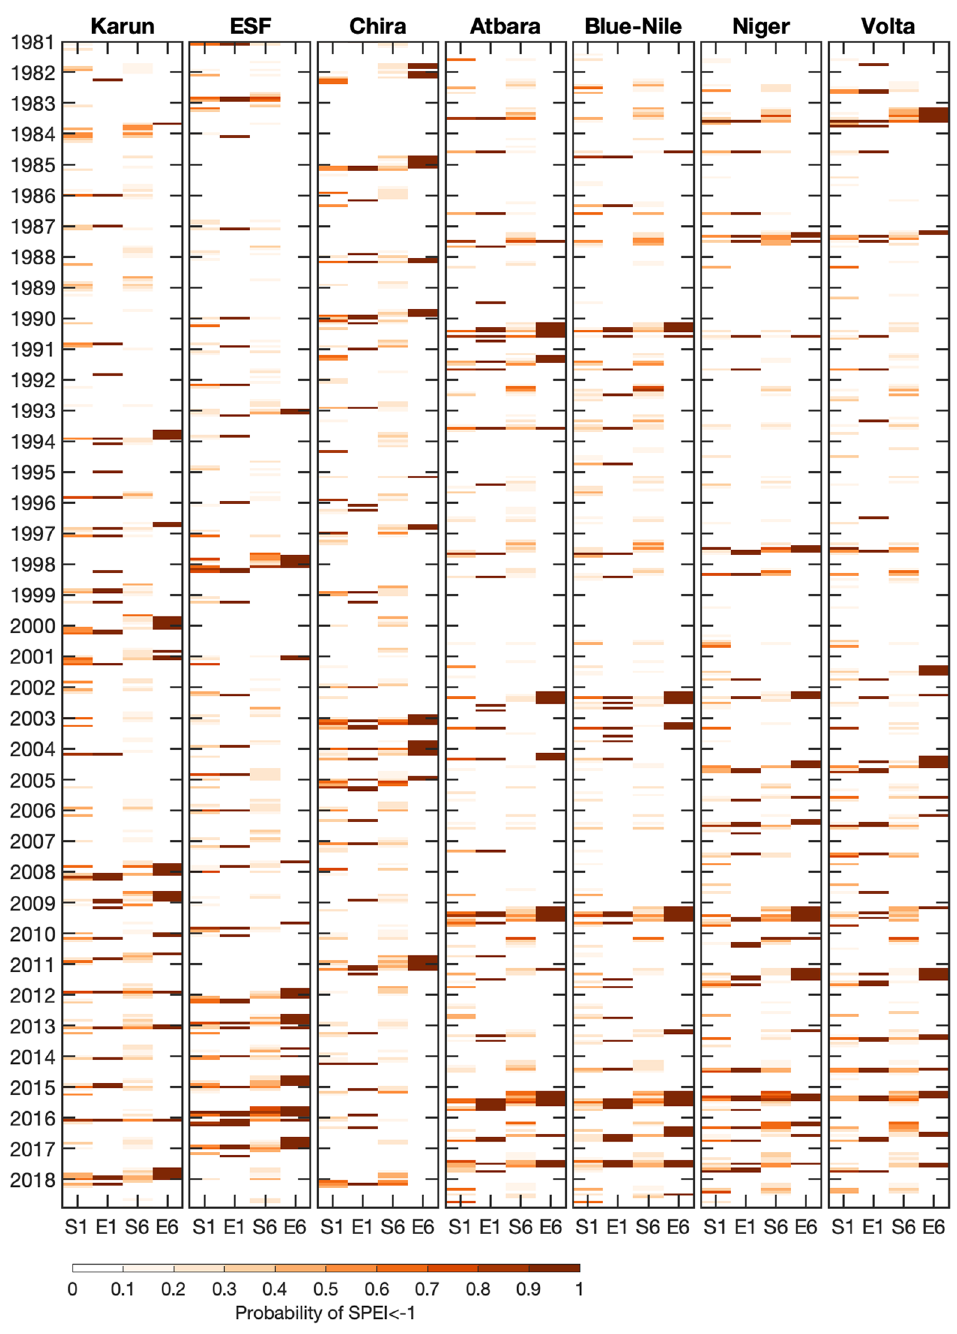
Figure 3. Forecast probability and occurrence of short- and long-term drought. The probability of SPEI1 < − 1 (1) and SPEI6 < − 1 (6) for SEAS5 (S) and ERA5 (E) are provided for the rainy seasons of the seven semi- arid regions from 1981-2018. The confinement of the analysis to the basins’ rainy seasons allows a simplified overview of drought events and respective forecast probabilities when droughts are mainly driven by rainfall shortage. The used time periods for aggregation of SPEI6 are depicted with the red bars in Fig.